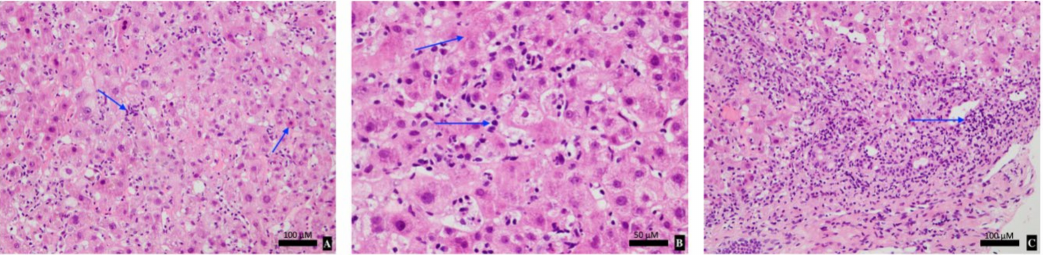
Figure 1. Histologic examination of liver lobule with hematoxylin and Eosin (H&E) staining demonstrating features of immune checkpoint inhibitor (ICI)-induced hepatitis with moderate lobular hepatitis, scattered apoptic hepatocytes ( A ), necro-inflammatory foci with lymphocytosis ( B ) and portal inflammation with interface activity ( C